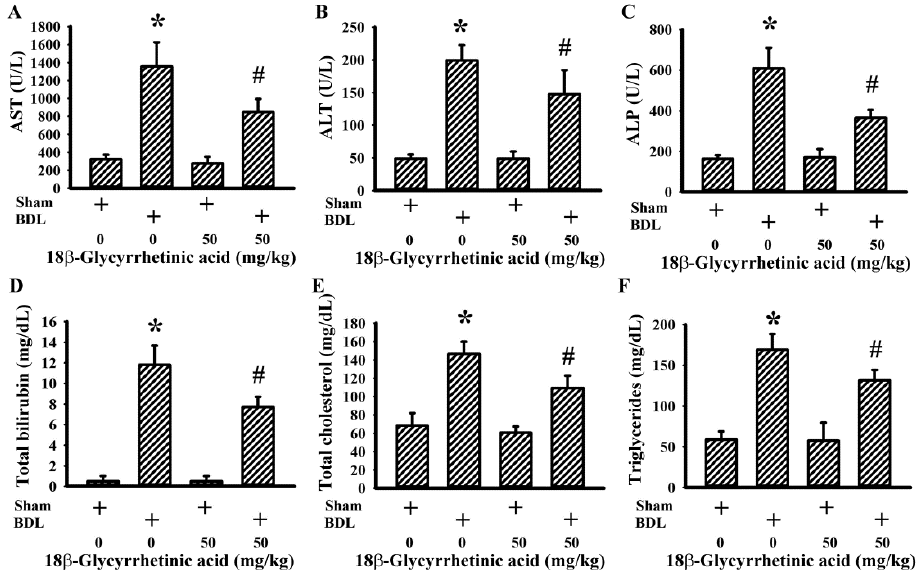
Figure 2. 18 β -Glycyrrhetinic acid decreased serum biochemical parameters in the treatment study. Serum levels of AST activity ( A ), ALT activity ( B ), ALP activity ( C ), total bilirubin ( D ), total cholesterol ( E ), and triglycerides ( F ) were measured. * p < 0.05 vs. the sham vehicle group and # p < 0.05 vs. the BDL vehicle group, n = 8.